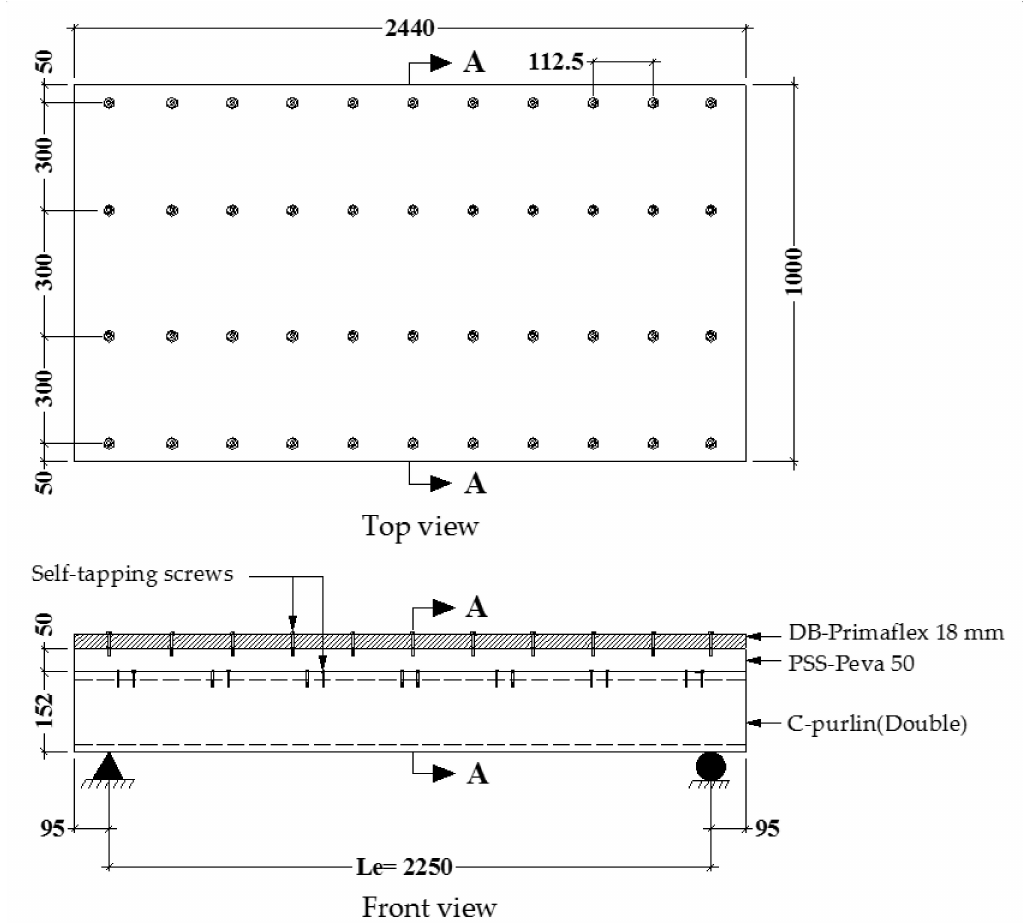
Figure 3. CBPDS specimen with parallel PSS direction (all dimensions in mm).